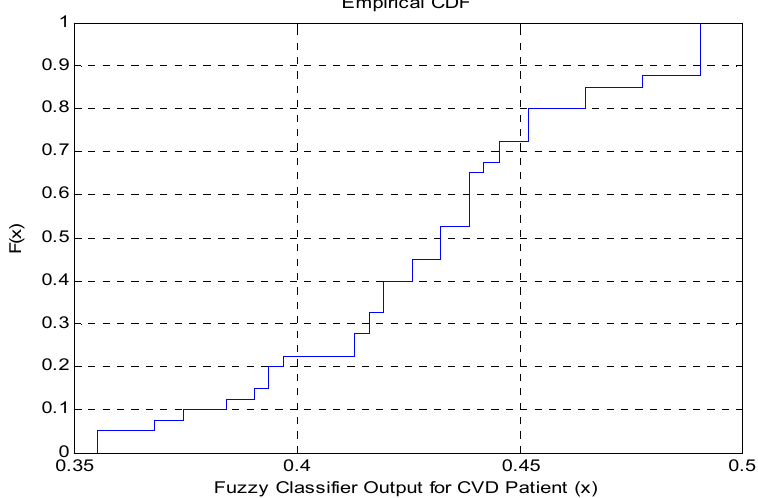
Figure 3. Cumulative Density Function (CDF) plot of the fuzzy modelled output.